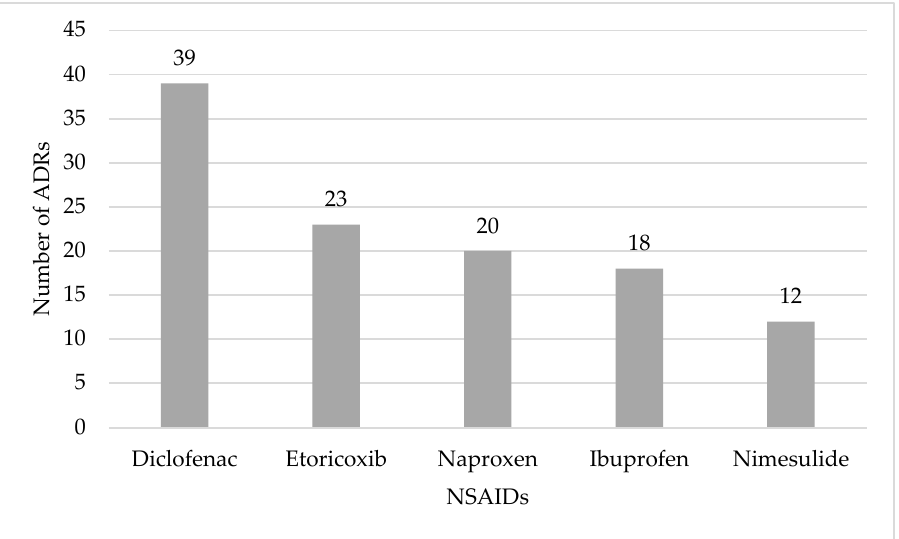
Figure 1. Single non-steroidal anti-inflammatory drugs (NSAIDs) involved in suspected adverse drug reaction (ADR) reports spontaneously reported to the Portuguese Pharmacovigilance System from 2008 to 2018 for people aged 65 years or older: the top five.